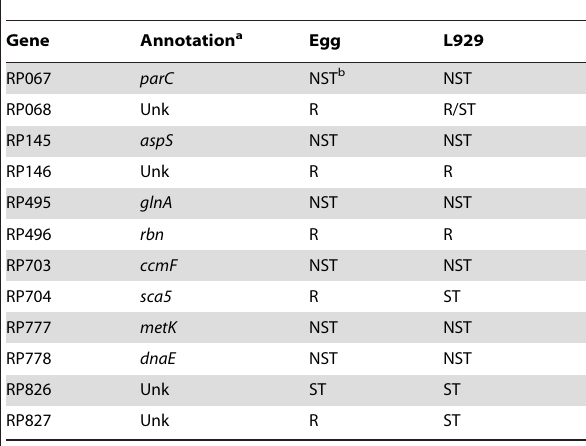
Table 3. Summary of Gene Termination